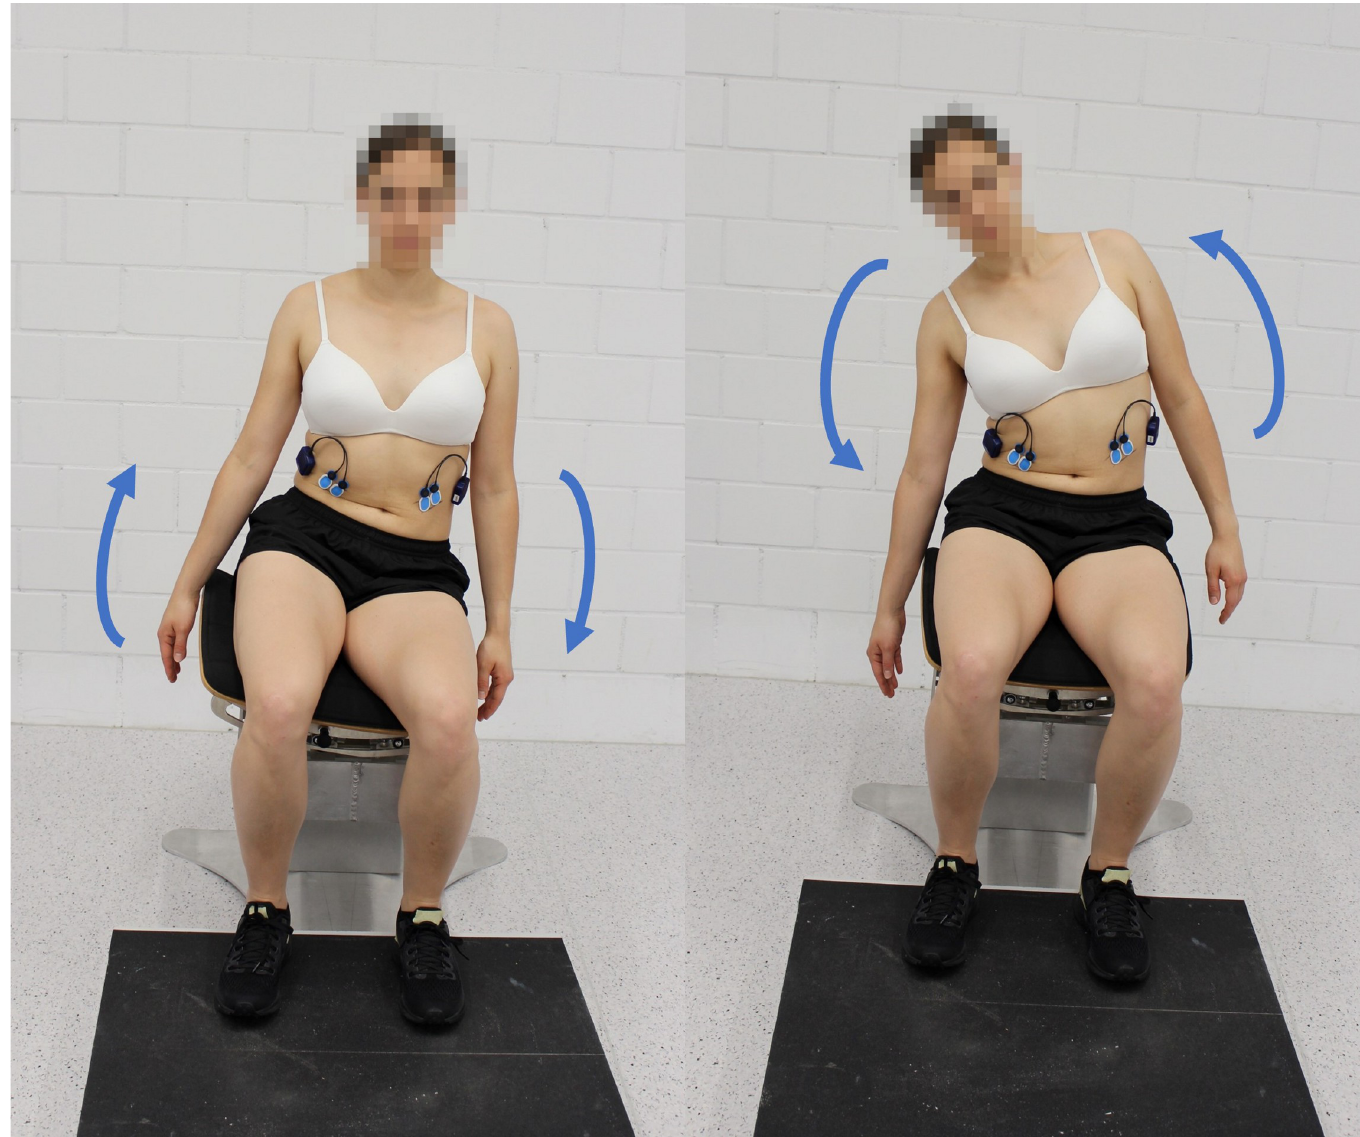
Fig 2. Trunk control exercises with movement initiated by the pelvis (left) and movement initiated by the trunk (right) on the mobile seat.